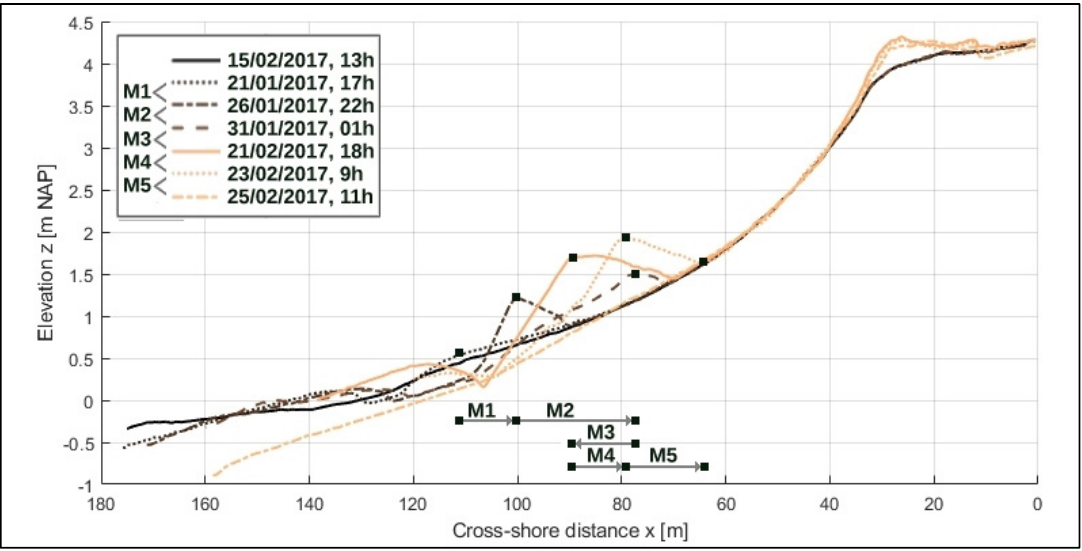
Figure 7 . Bed levels of 7 selected low water periods, from 15 January to 25 February 2017. The changes around 20–30 m (cross-shore distance) are caused by bulldozers flattening the beach for the tourist season. The detected movements of the intertidal bar (M1–M4) are indicated with arrows. M5 indicates the destruction of the bar.